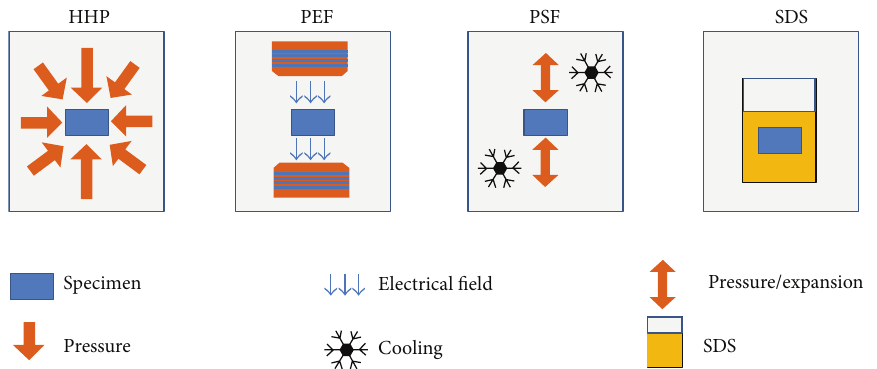
Figure 1: Different techniques used to treat the samples. Specimen and physical/chemical effects influencing the tissue structure are